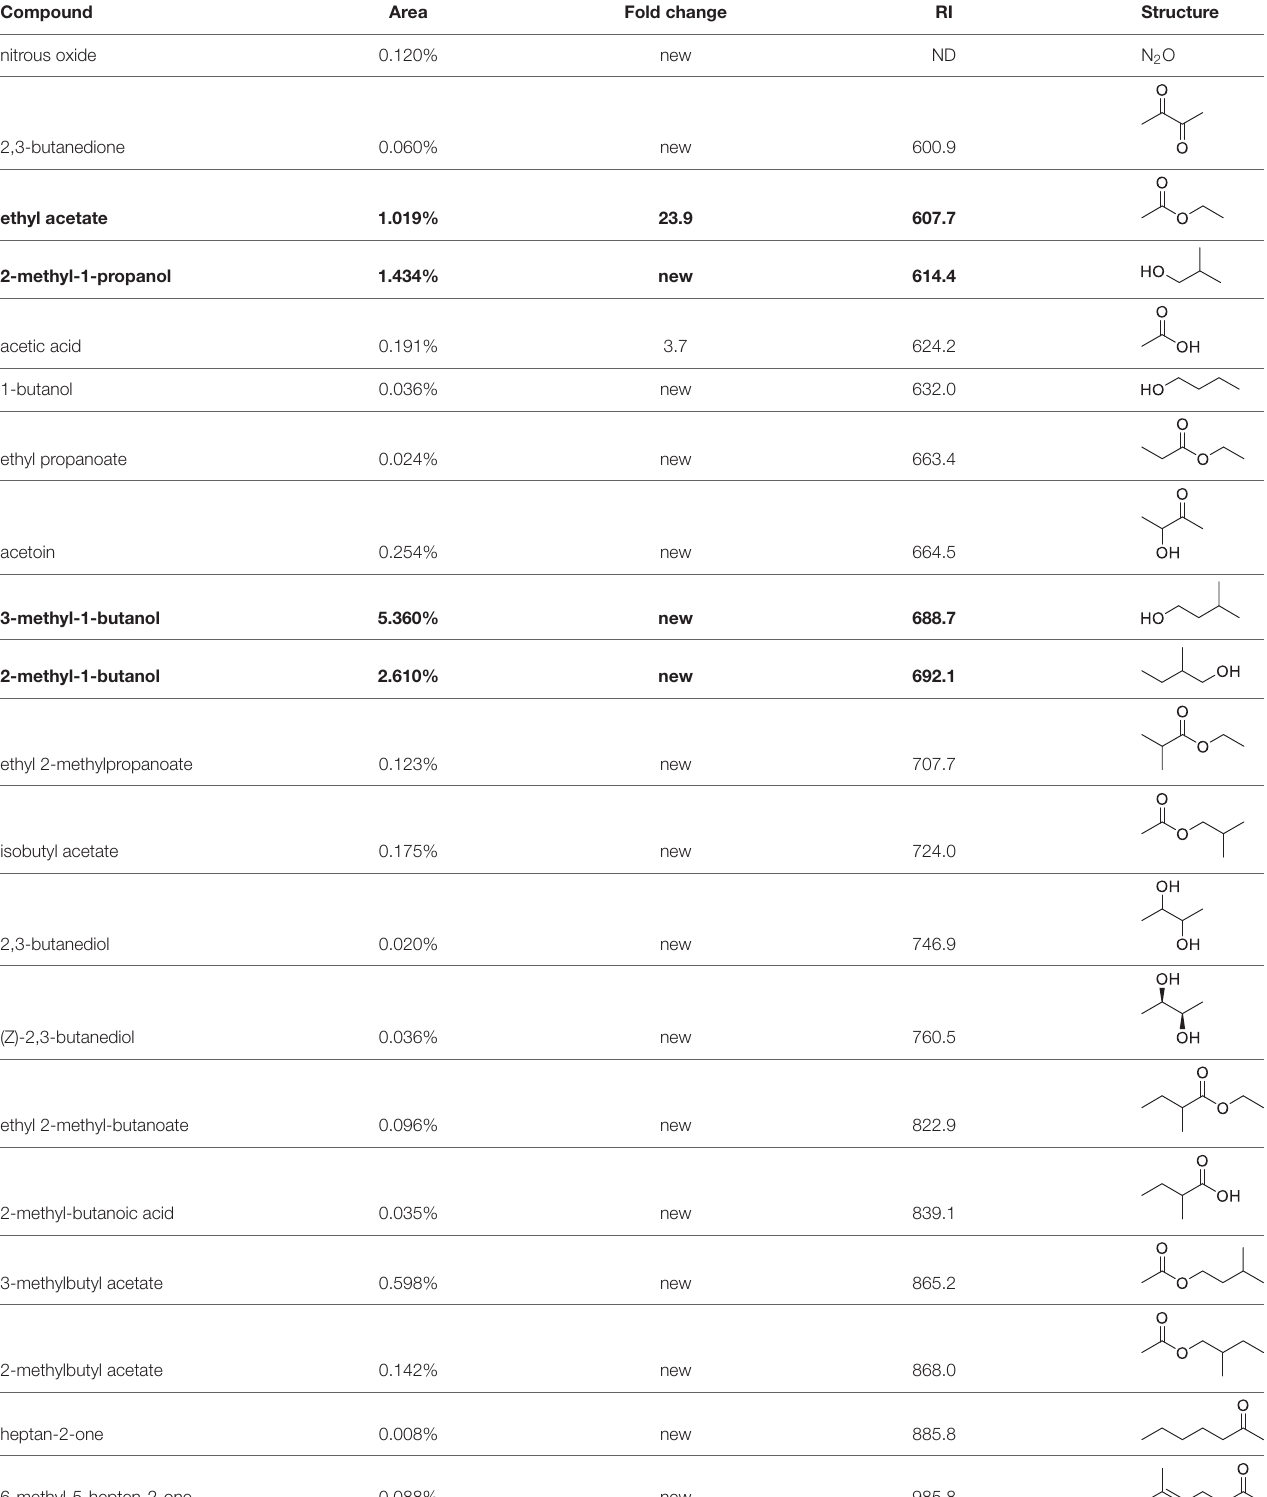
TABLE 1 | VOCs identified from P. nodorum grown on Fries media using HS-SPME-GC-MS. Compound Area Fold change RI Structure nitrous